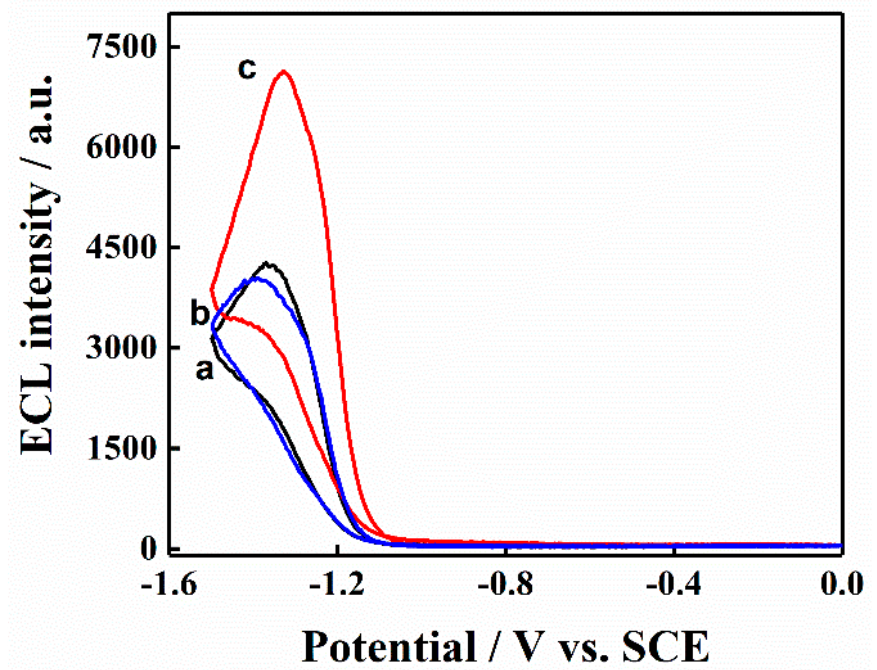
Figure 8. ECL potential curves of TCPP-Zn-(S)-BINOL/GCE in 10 mM HEPES containing 12 mM H 2 O 2 before (a) and after the addition of 2 mM D-Tyr (b) and L-Tyr (c).